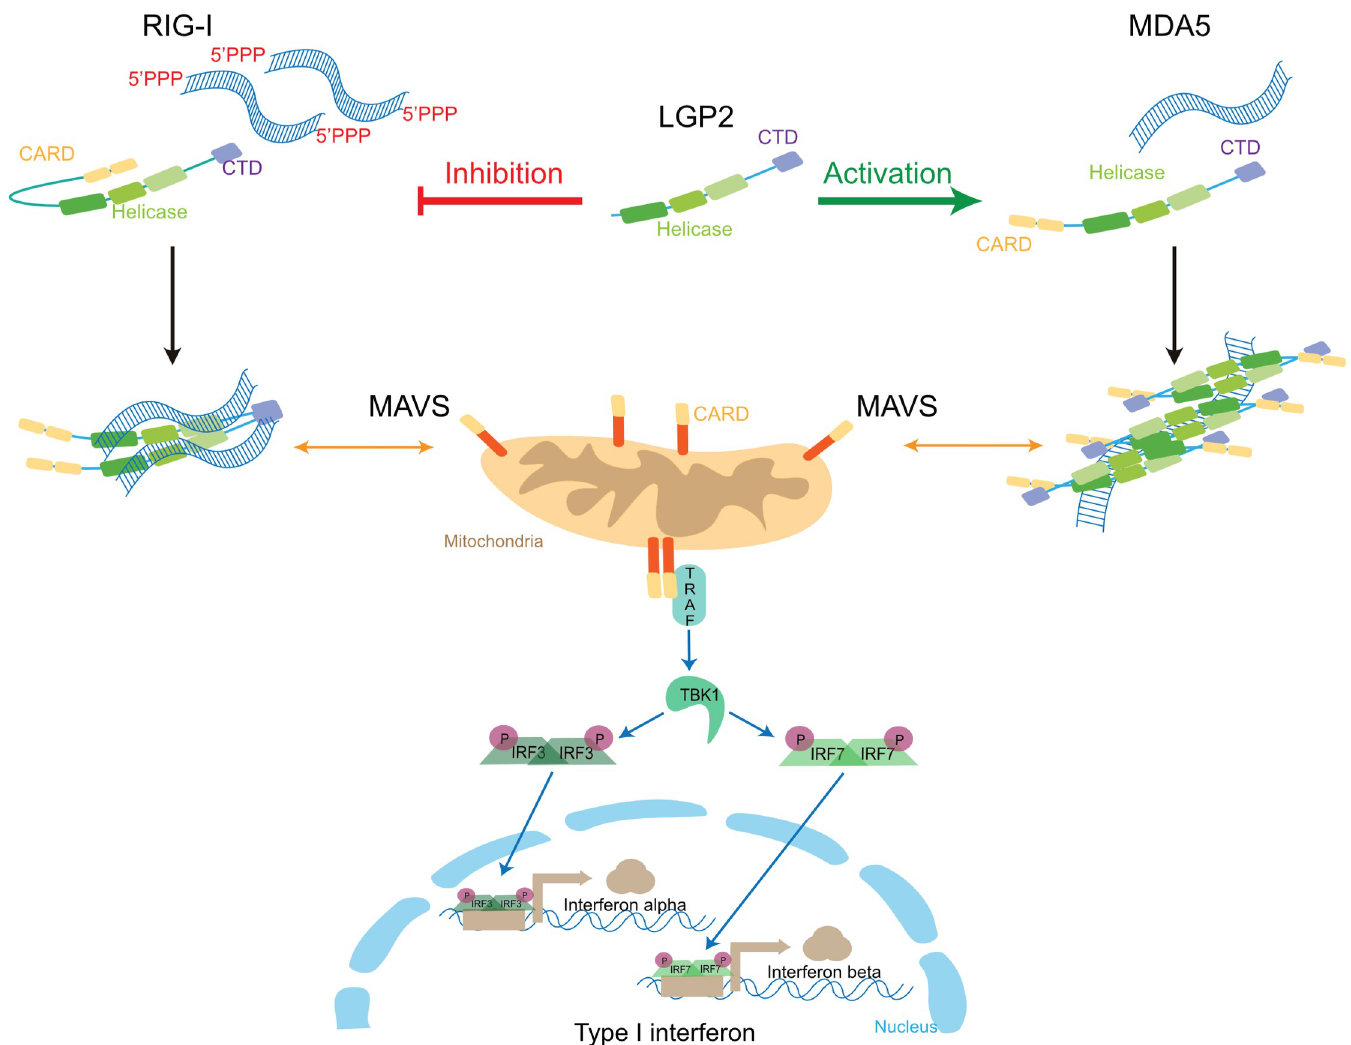
Fig 4. Mode of action of RLRs upon viral infection. Both dsRNA replication intermediates and 5 0 terminal motifs can be recognized by cytosolic RLRs. RIG-I detects 5 0 di- or tri-phosphorylated dsRNA via its CTD and helicase domains whereas MDA5 recognizes long dsRNA structures. Upon dsRNA binding, RIG-I opens and homodimerizes to mediate interactions with MAVS CARD domains at the surface of mitochondria. By contrast, MDA5 constantly shifts between open and close conformations and when it is activated, it polymerizes along the dsRNA forming helicoidal filament to expose its CARD domains and activate MAVS. Once activated, MAVS aggregates and triggers a signaling cascade through the TRAF protein that activates the TBK1 kinase. The latter then phosphorylates the cytosolic transcription factors, IRF3 and IRF7, thereby allowing their dimerization and their translocation into the nucleus where they activate the transcription of IFN-I genes. CARD, caspase activation and recruitment domain; CTD, carboxyl-terminal domain; dsRNA, double-stranded RNA; IFN, interferon; MAVS, mitochondrial antiviral signaling adaptator; MDA5, melanoma differentiation–associated gene 5; RIG-I, retinoic acid–inducible gene I; RLR, RIG-I-like